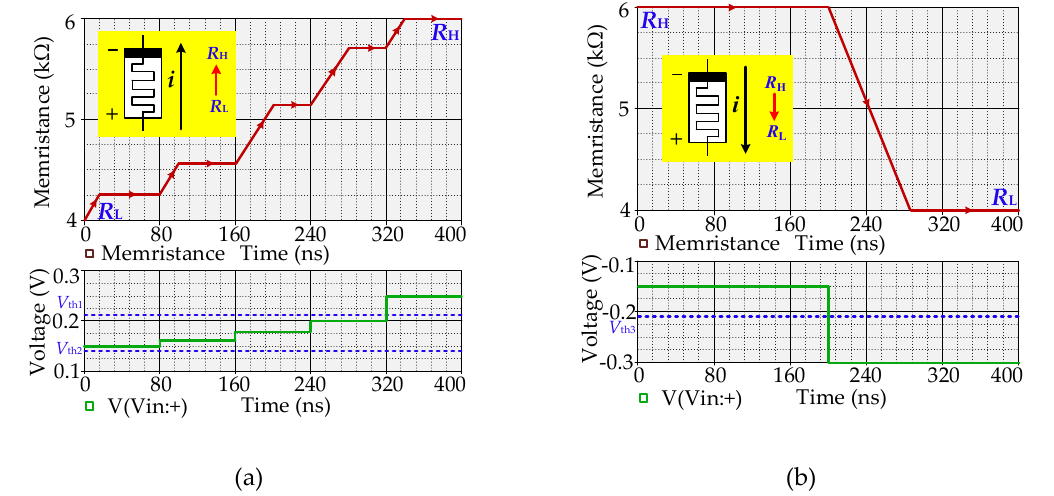
Figure 2. ( a ) The memristance variation under a positive voltage pulse. ( b ) The memristance variation under a negative voltage pulse.